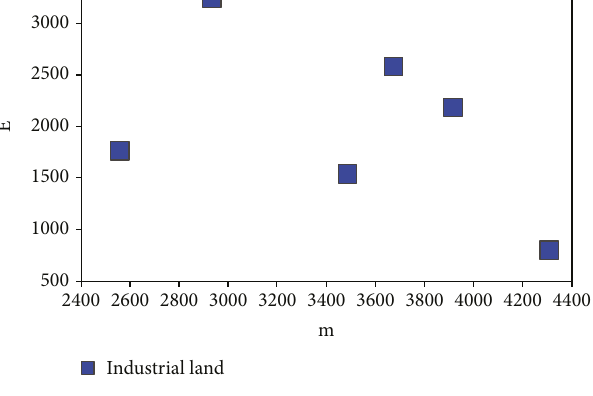
Figure 7: Industrial land layout